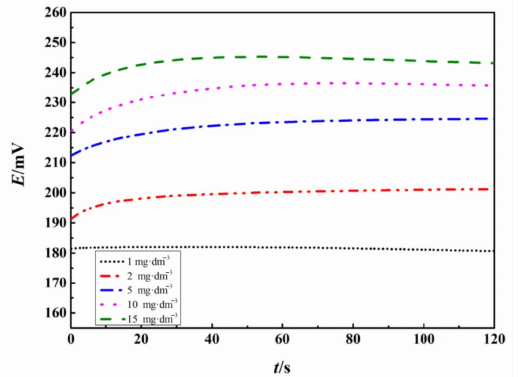
Figure 3. The variation of OCP ( E ) of the Fc-CPE electrode with immersion time in 3.5 wt.% NaCl solution containing different TRC concentrations.